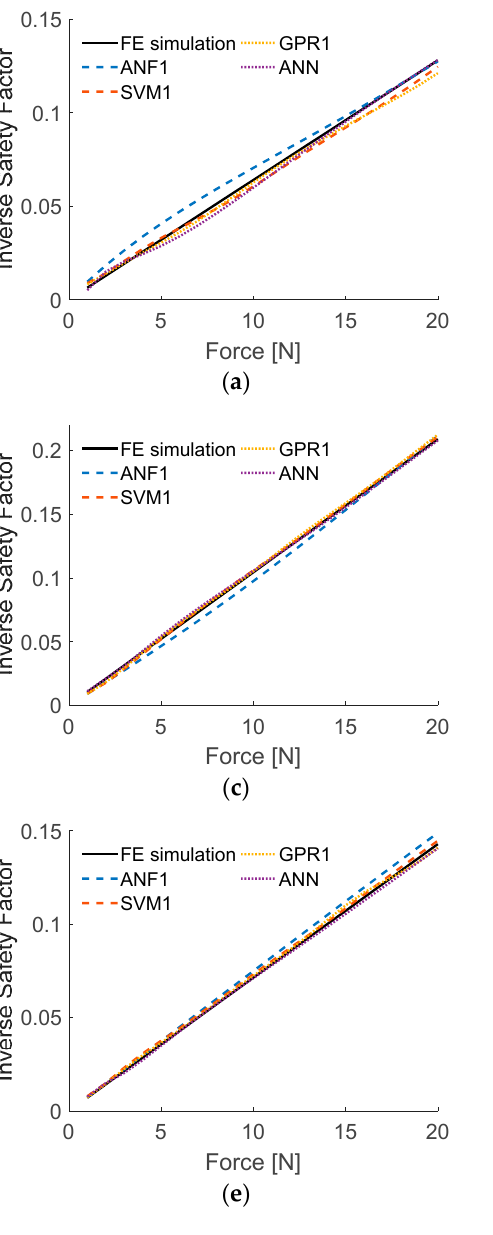
Figure 13. Results of testing chosen models of different methods: ( a ) load case LC1, numerical input data; ( b ) load case LC1, experimental input data; ( c ) load case LC2, numerical input data; ( d ) load case LC2, experimental input data; ( e ) load case LC3, numerical input data; ( f ) load case LC3, experimental input data. Table 5. Comparison of accuracy and computational time for chosen models.